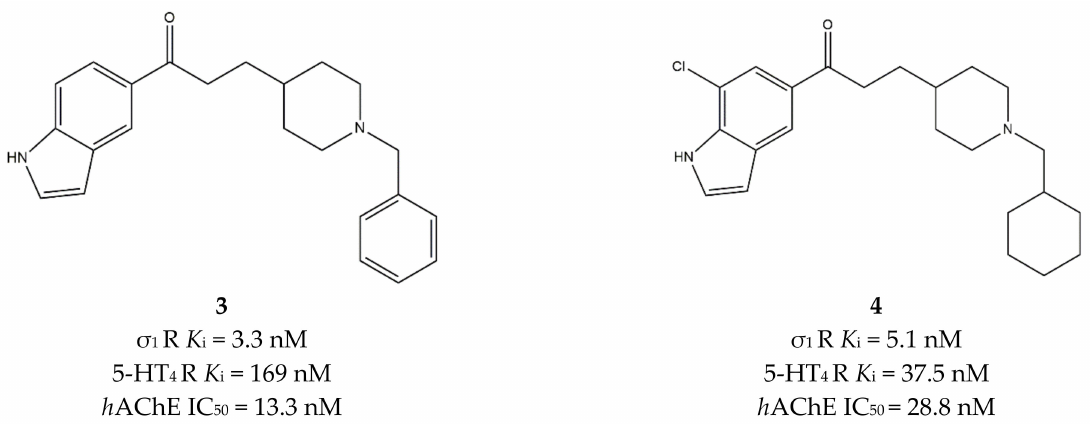
Figure 4. Compounds ( 3 ) and ( 4 ) structures and their K i and IC 50 values σ 1 receptor ( σ 1 R), serotoninergic 5-HT 4 receptor (5-HT 4 R) and human acetylcholinesterase ( h AChE)